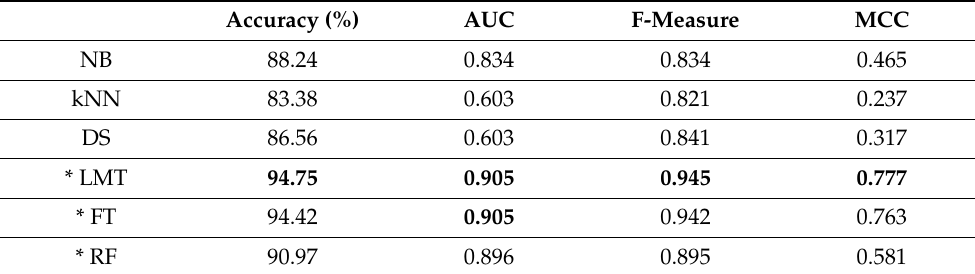
Table 3. The CCP performance of DF models and ML classifiers on Dataset 1.